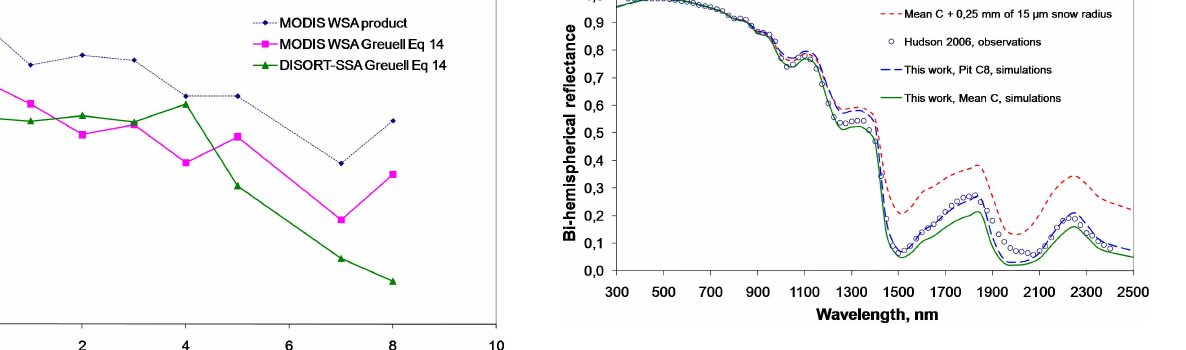
Fig. 20. Calculated bi-hemispherical reflectance (i.e. albedo) of snow near Dome C, and comparison with the measurements of Hud- son et al. (2006), performed under overcast conditions. Calculations using the stratigraphy of pit C8 match the observations of Hudson et al. (2006) fairly well. If a thin high-SSA layer is added, the albedo is much larger than observations in the